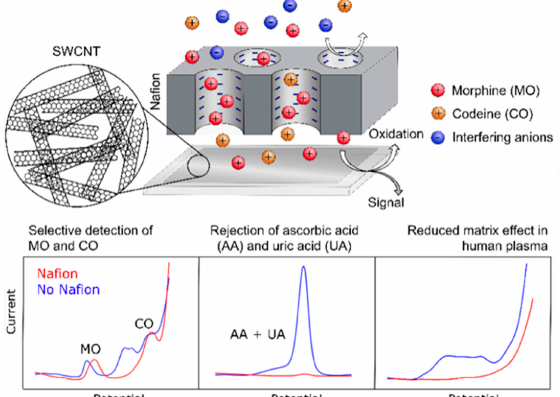
Figure 5. Top : Representation of the electrode comprising Nafion and SWCNT for selective detection of morphine and codeine. Down : Cyclic voltammograms (I vs. V) for the neat SWCNT electrode (blue) and Nafion-coated SWCNT electrode (red). Reprinted from [59], copyright 2019, American Chemical